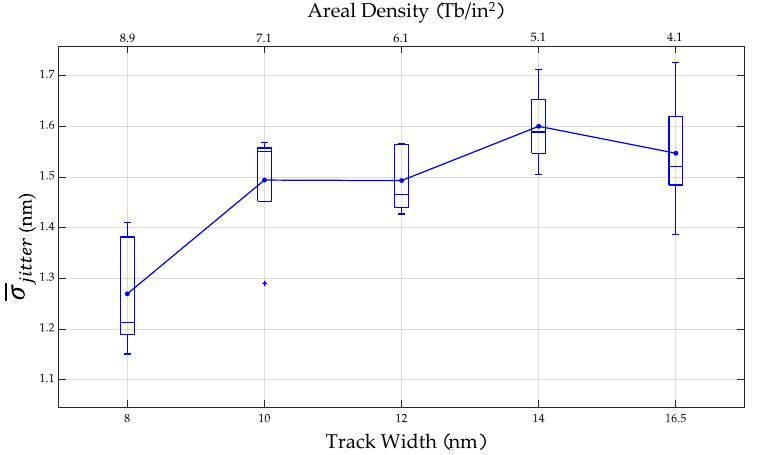
Figure 7. The σ jitter for track width and areal density Figure 7. The 𝜎 𝑗𝑖𝑡𝑡𝑒𝑟 for track width and areal density variation. Figure 7. The (cid:2026) (cid:3037)(cid:3036)(cid:3047)(cid:3047)(cid:3032)(cid:3045) for track width and areal density variation.